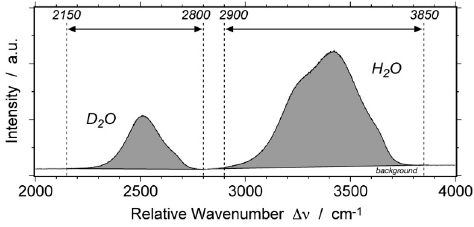
Figure 5. Example of a Raman spectrum of a D 2 O-H 2 O mixture from a single fluid inclusion.